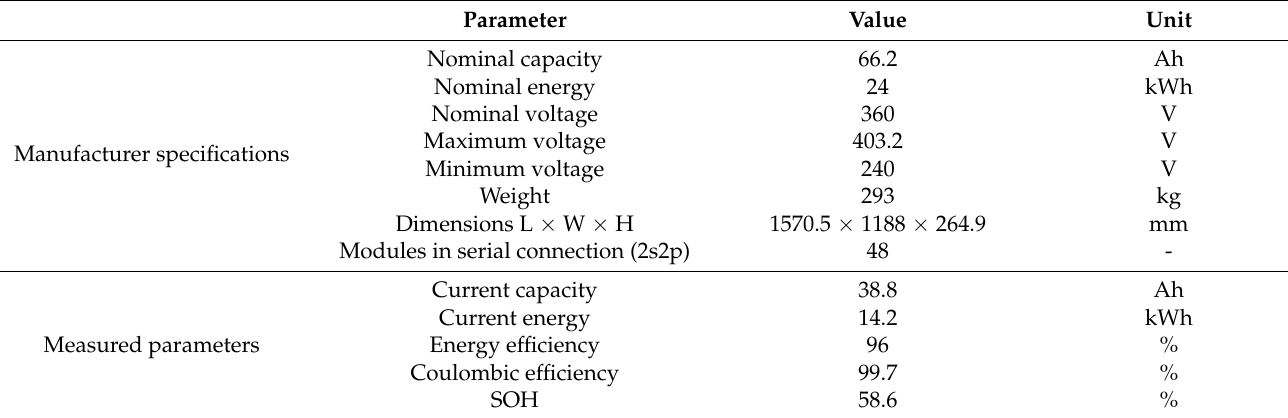
Table 1. Main parameters of the battery pack.